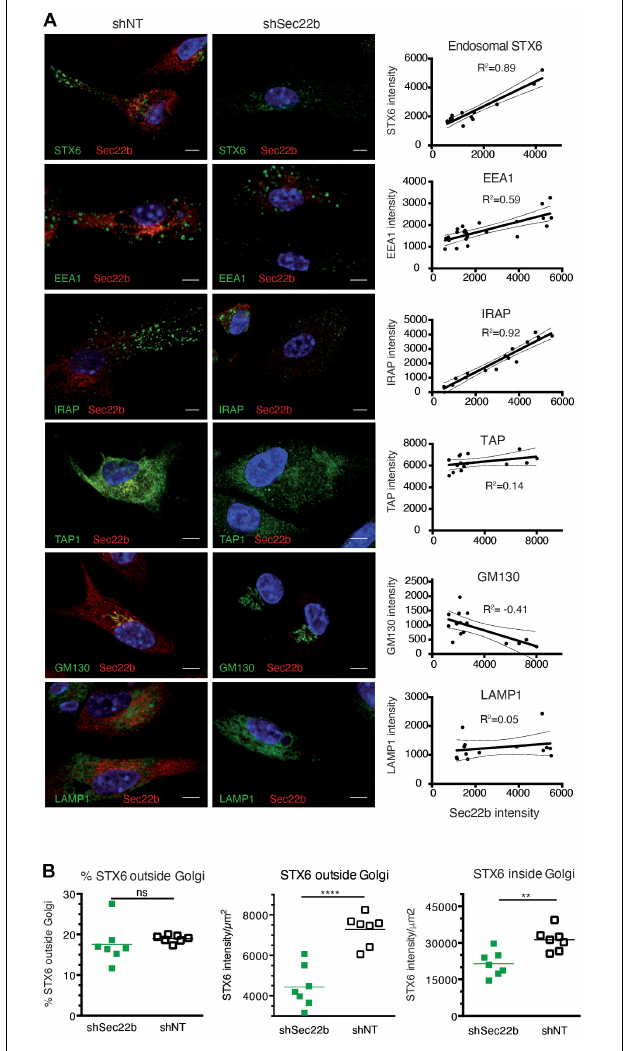
FIGURE 5 | Sec22b knockdown results in severe perturbation of insulin-regulated aminopeptidase (IRAP) + STX6 + endosomes. (A) Bone marrow-derived dendritic cells (BM-DCs) were transduced with shNT or shSec22b lentiviruses, stained for Sec22b, and analyzed by confocal microscopy with identical settings for shNT and shSec22b samples. The adjacent graphs show the correlation between the mean fluorescence intensities for Sec22b and for a second marker, each dot representing a different cell. Correlation coefficients were computed using exclusively unsaturated images. (B) BM-DCs were transduced as in panel (A) and stained for Sec22b and STX6. The integrated density of STX6 staining was measured in the Golgi area and outside of it for each cell analyzed using unsaturated images. **** p < 0.0001; ** p < 0.001; ns, not